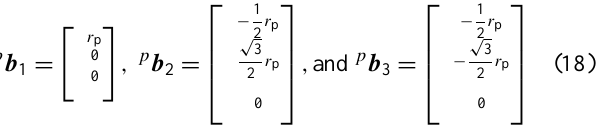
at the platform form an equilateral triangle circumscribed in a circle with centre p and radius r p . The line of action of the prismatic joints intersects the base Oxy plane at A i also forming an equilateral triangle. The distance from O to A i is the base platform radius r b .